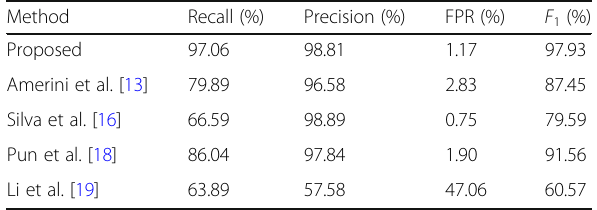
Table 4 Detected results for CMHD2 dataset under rotation Method